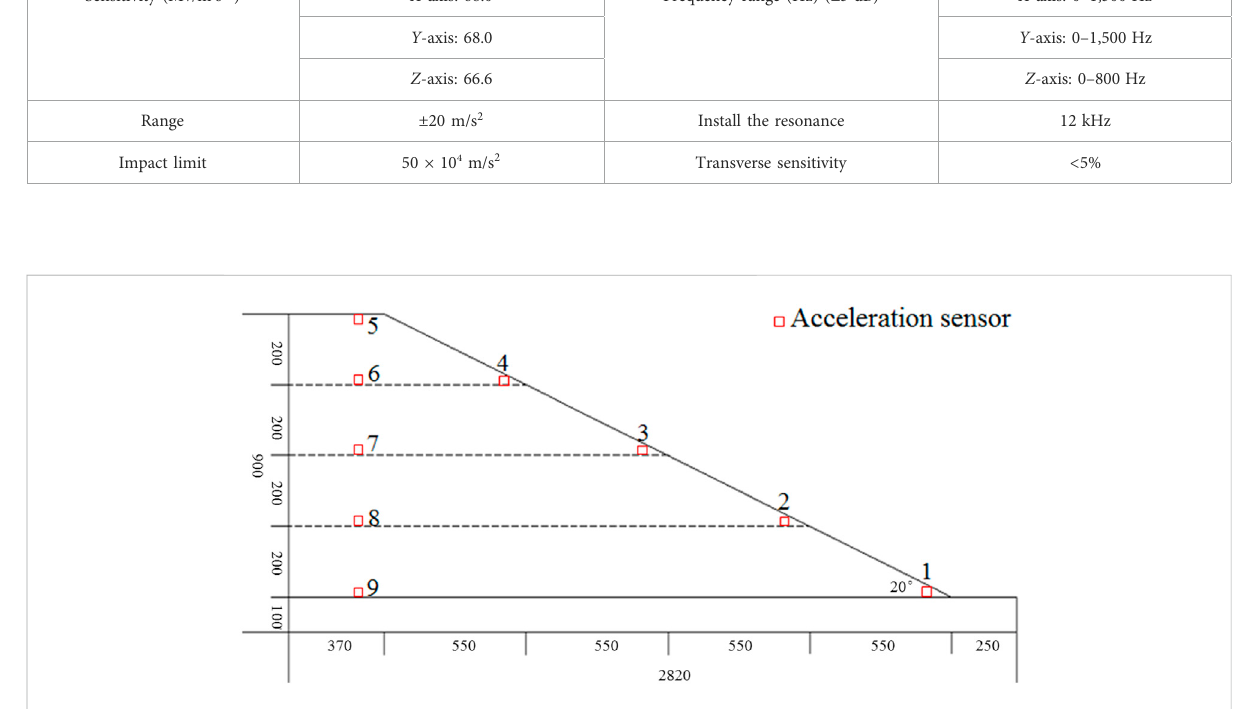
FIGURE 4 Layout scheme of the acceleration sensor (unit: mm).